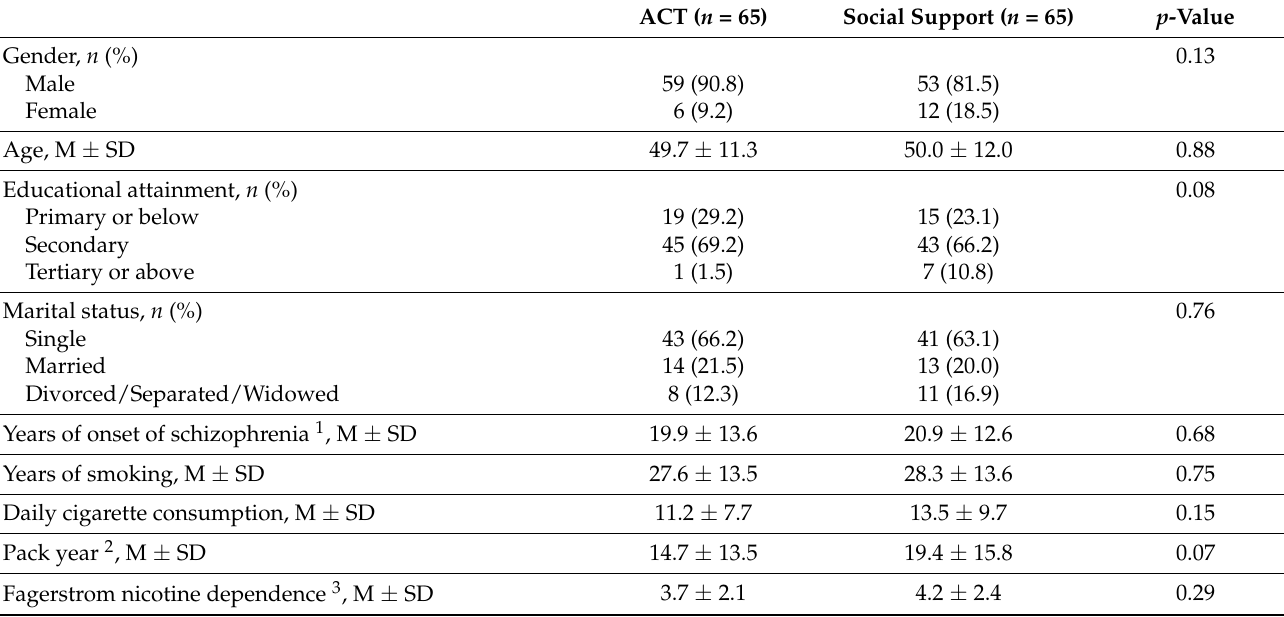
Table 1. Baseline characteristics of the participants ( n =